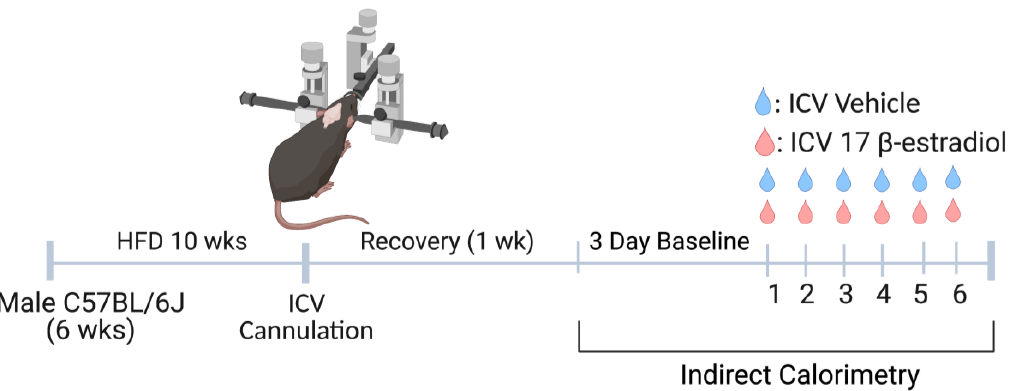
Figure 1. Schematic overview of the experimental protocol. Male C57Bl/6J mice were fed a high fat diet (HFD) for 10 weeks and then instrumented with an intracerebroventricular (ICV) cannula. Following recovery and baseline indirect calorimetry measurements, ICV 17- β -estradiol (1.5 µ g in 1 μL) or vehicle control (saline) was administered once daily over 6 days.